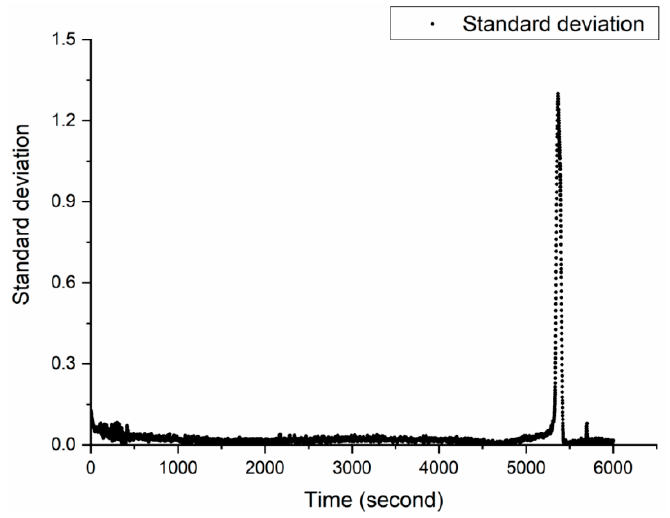
Figure 2. Deviation of evaporation rate of deionized water.